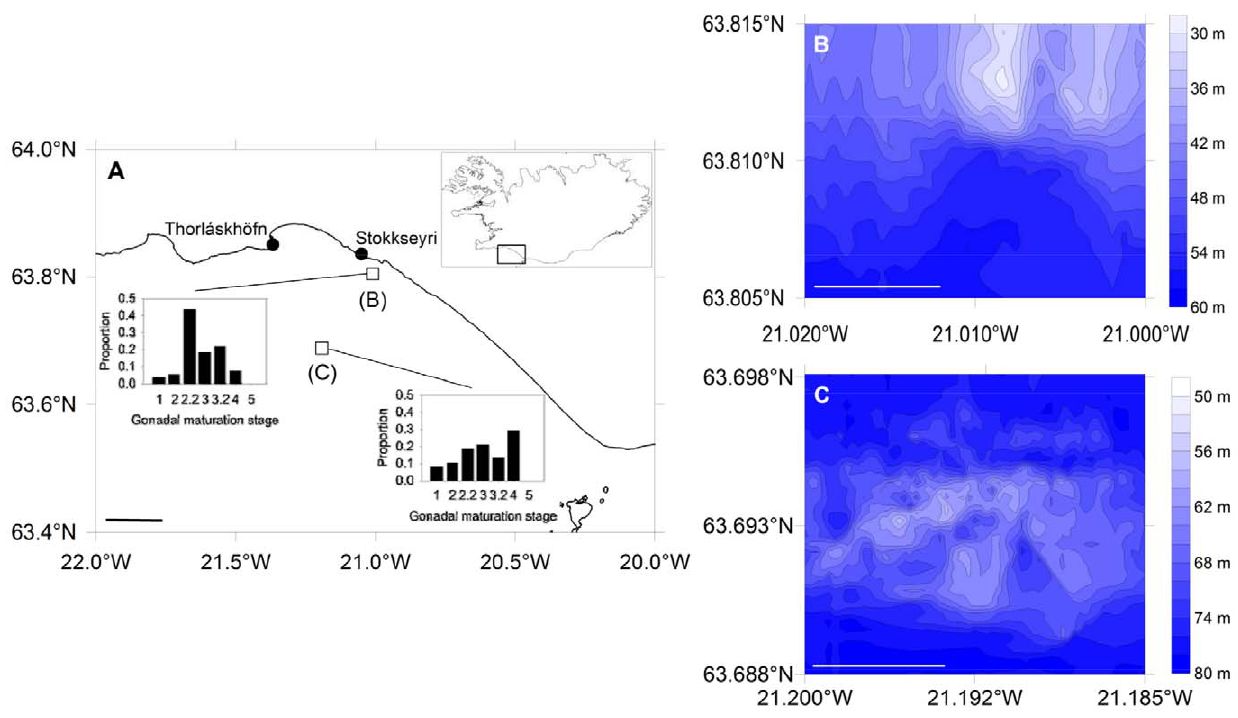
Figure 1. Map of study area off southwestern Iceland (A) with sample locations indicated by open boxes. Inset figures represent the proportion of cod exhibiting a particular gonadal maturity stage (1: immature; 2: maturing; 2.2: final stages of maturation; 3: ripe and running; 3.2: near spent; 4: spent/recovering; 5: omitted spawning) sampled from these sites during 17–20 April 2009 as part of the annual spring groundfish survey conducted by Hafrannso´knastofnunin. Scale bar represents 10 km. Bathymetric maps of Knarraro´s (B) and Lofstadarhraun (C). Contour lines indicate 2-m isobaths. Scale bars in panels (B) and (C) represent 500 m.